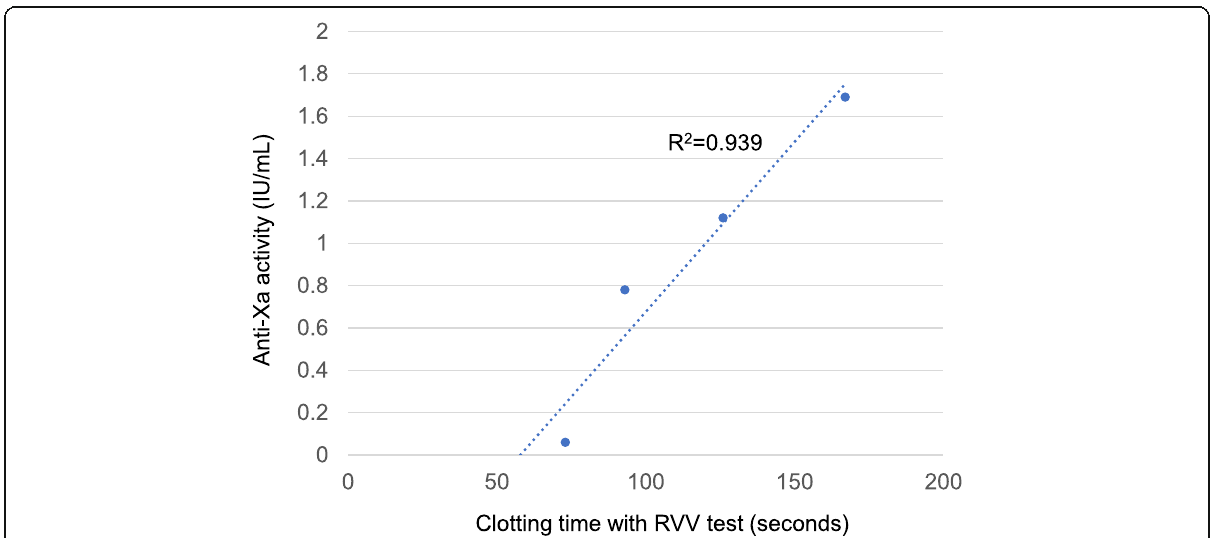
Fig. 2 Relation between clotting time with the RVV test and chromogenic anti-Xa